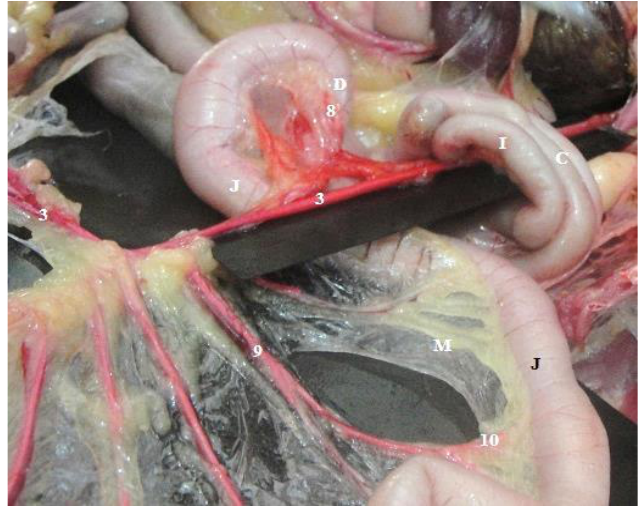
Figure 5 . Photograph illustrates arterial blood supply of jejunum in male turkey, 3: Cranial mesenteric a.,9:jejunal a. ,10: marginal intestinal a. , D: duodenum j : jejunum ,I :ileum, green arrow duodenal-jejunal flexure ,M: Mesentery